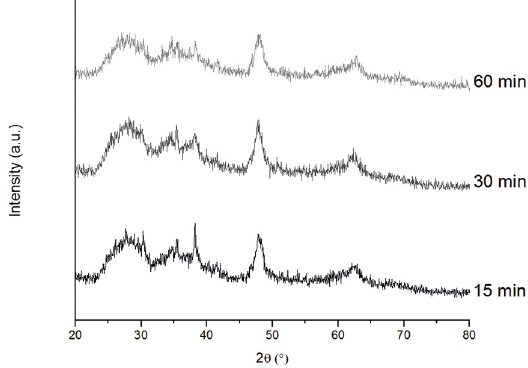
Figure 4: XRD patterns for the syntheses material using 1 M NaOH at 150 ° C, using different times 15, 30 and 60 min.